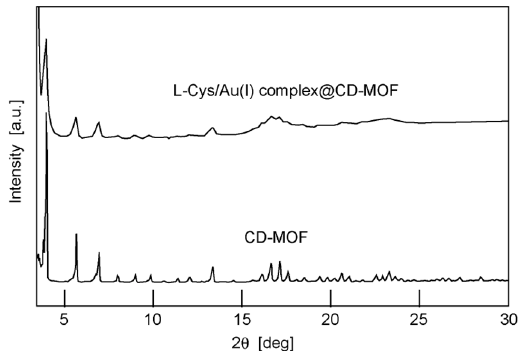
Figure 5. X-ray diffraction (XRD) patterns of CD-MOF and L-Cys/Au(I)@CD-MOF.